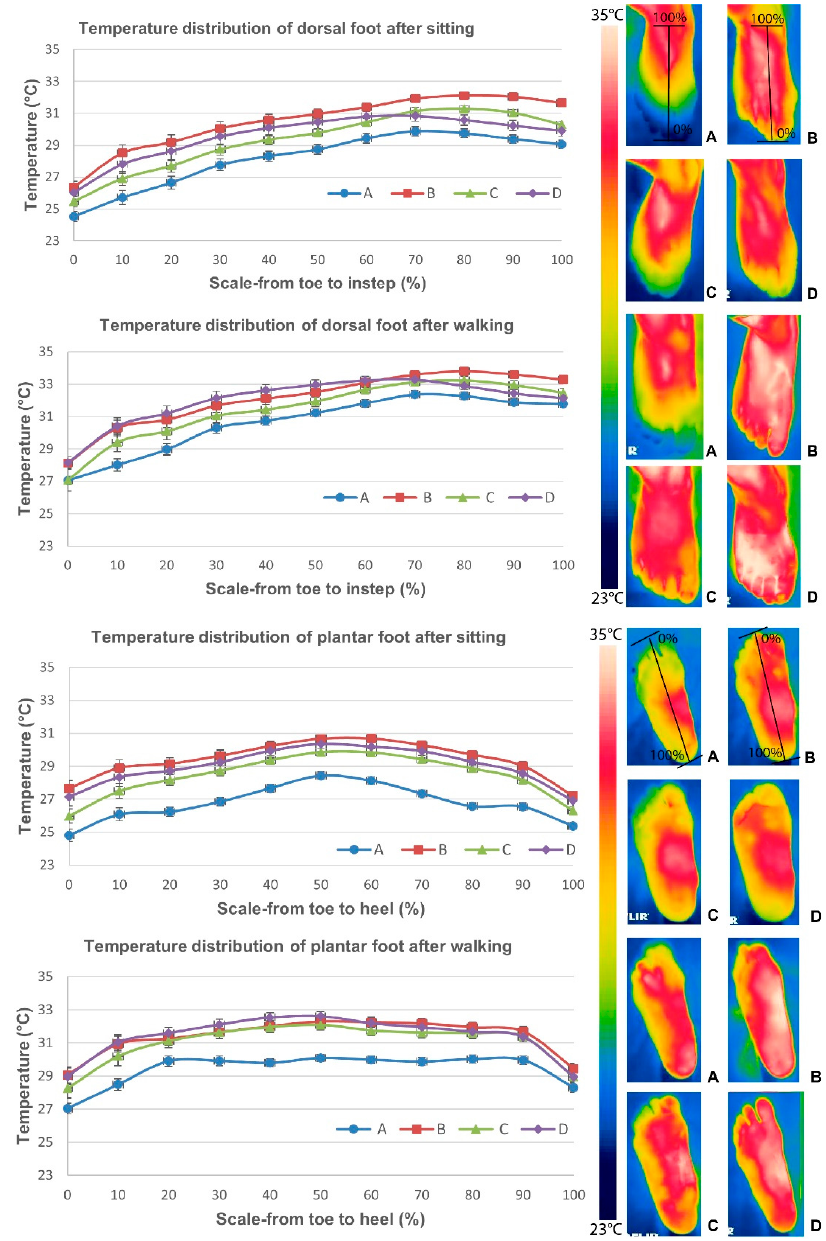
Figure 5. Temperature distribution (mean) of dorsal and plantar sides of foot based on four experi- mental conditions after sitting and walking, where A: barefoot, B: leather sports shoes, C: mesh sports shoes, and D: closed-toe slipper.